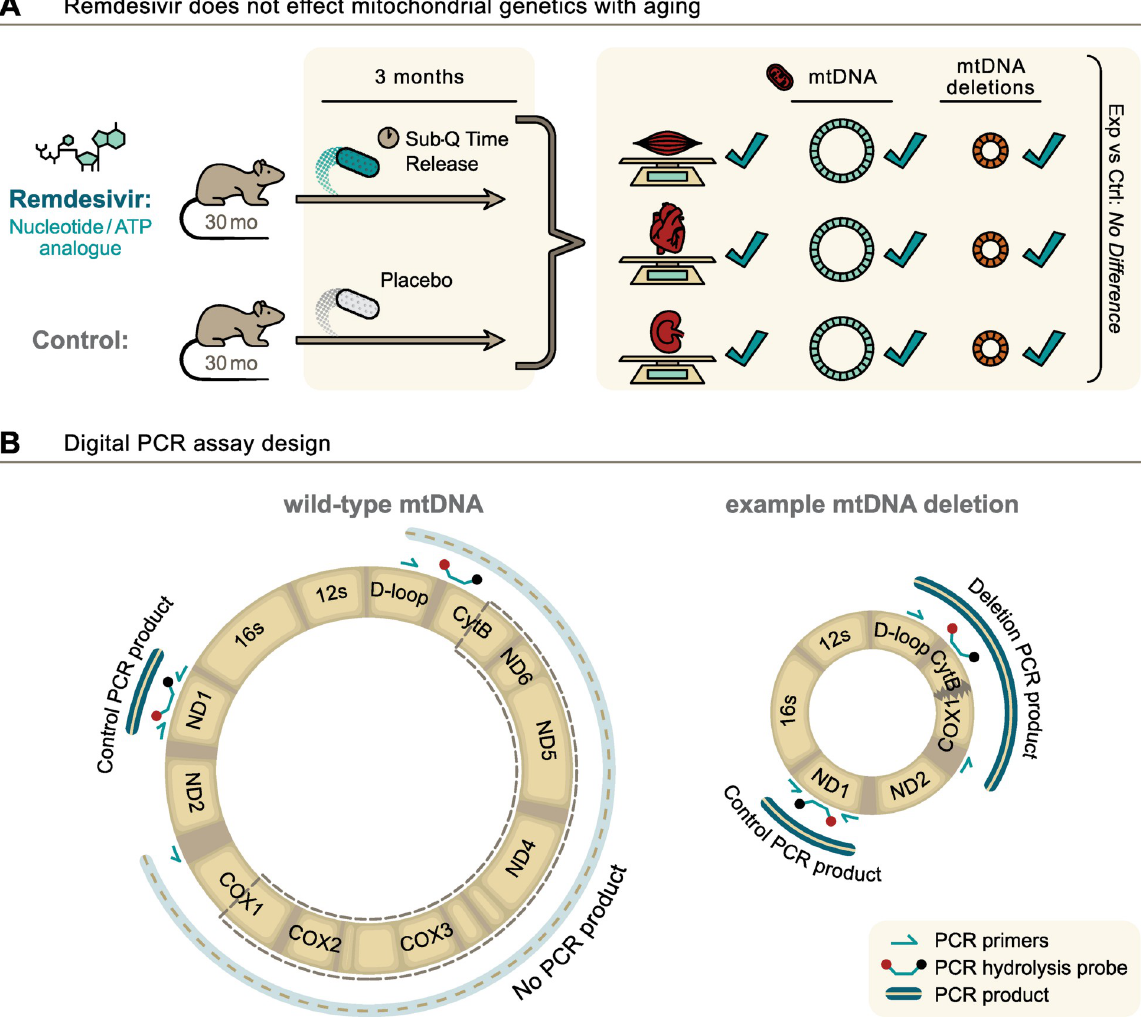
Fig 1. Graphical abstract of the study (A) and design of digital PCR assay (B). Primers and probes are not drawn to scale. Primers and probe used to quantitate mtDNA deletion mutations flank the mitochondrial major arc to detect age-induced mtDNA deletion mutations. In the wild- type genome in the left panel, the major arc-flanking primers are too far apart for amplification. In the right panel, an example mtDNA deletion mutation has brought the major arc-flanking primers within range for amplification of a PCR product.